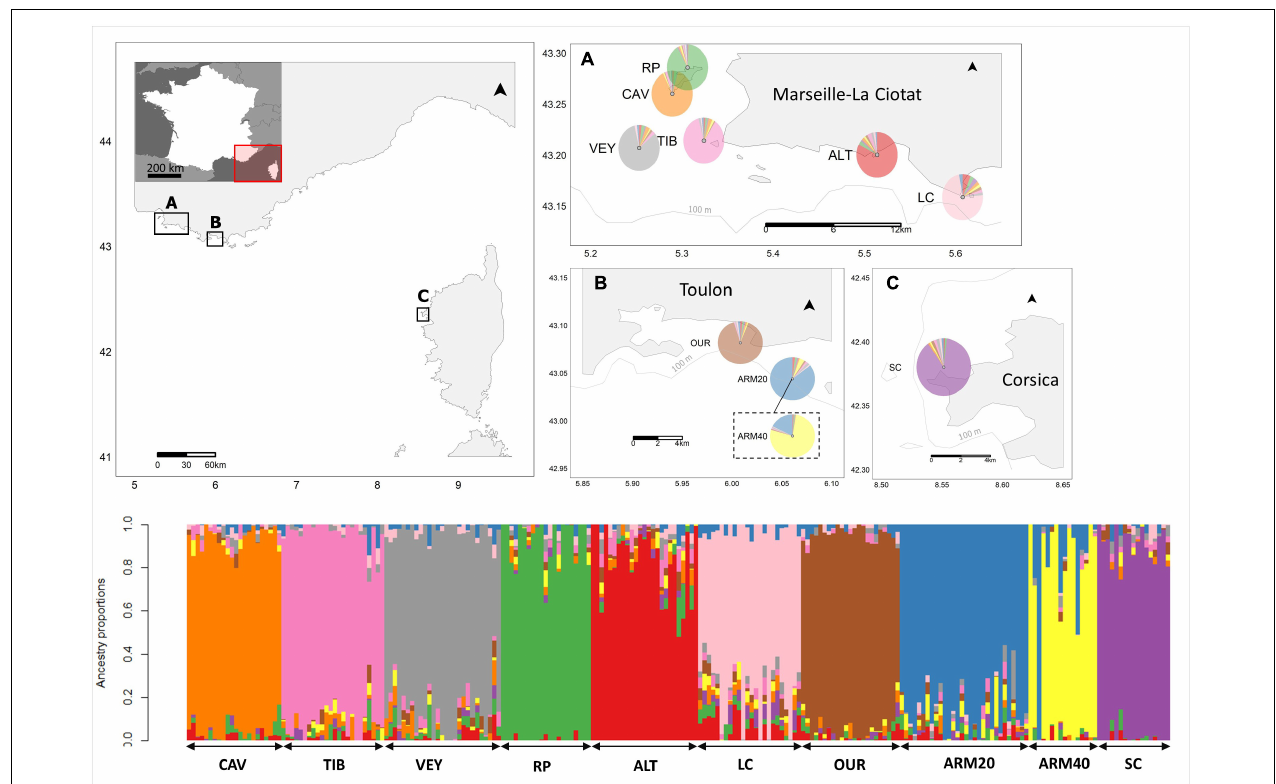
FIGURE 1 | Sampling map of Ericaria zosteroides and genetic ancestry estimates derived from sNMF at K = 10 clusters using the set of 10,755 putatively neutral SNPs. The pie plots indicate ancestry averaged over individuals per site, with different colors indicating admixture. The dotted box indicates that ARM20 and ARM40 populations have the same geographical position but differ by depth. Genetic ancestry is also reported at the individual level. Populations are labeled according to the nomenclature defined in Table 1